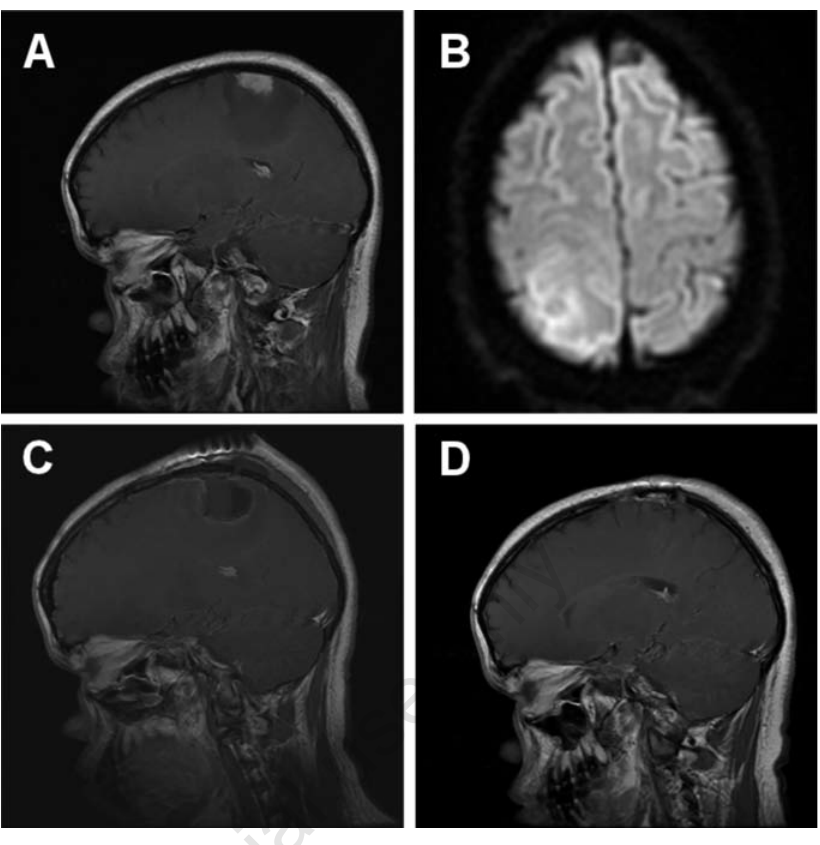
Figure 1. Sagittal T1-weighted magnetic resonance imaging (MRI) of the brain with gadolinium contrast. A) Preoperative image demonstrates a 2.6 ¥ 1.6 cm enhancing mass with surrounding edema. B) Axial diffusion-weighted MRI demonstrating perilesional edema but no solid areas of restricted diffusion to suggest abscess. C) Postoperative image one day after surgery demonstrating gross total resection. D) Postoperative image four months after surgery showing no recurrence.